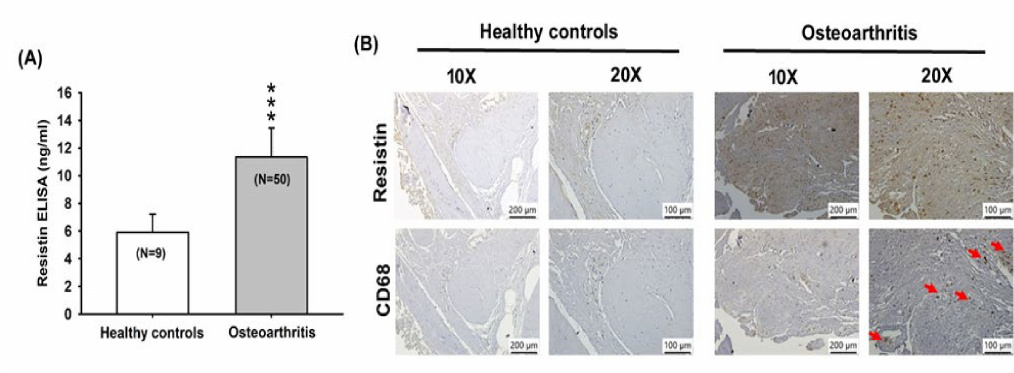
Figure 1. Resistin expression is increased among osteoarthritis (OA) patients. ( A ) Resistin serum levels in healthy controls (n = 9) and OA patients (n = 50) were quantified by the ELISA assay. ( B ) Immunohistochemistry (IHC) staining of resistin and CD68 (monocyte surface marker) for healthy controls (n = 10) and OA synovium (n = 10). *** p < 0.001 compared with healthy